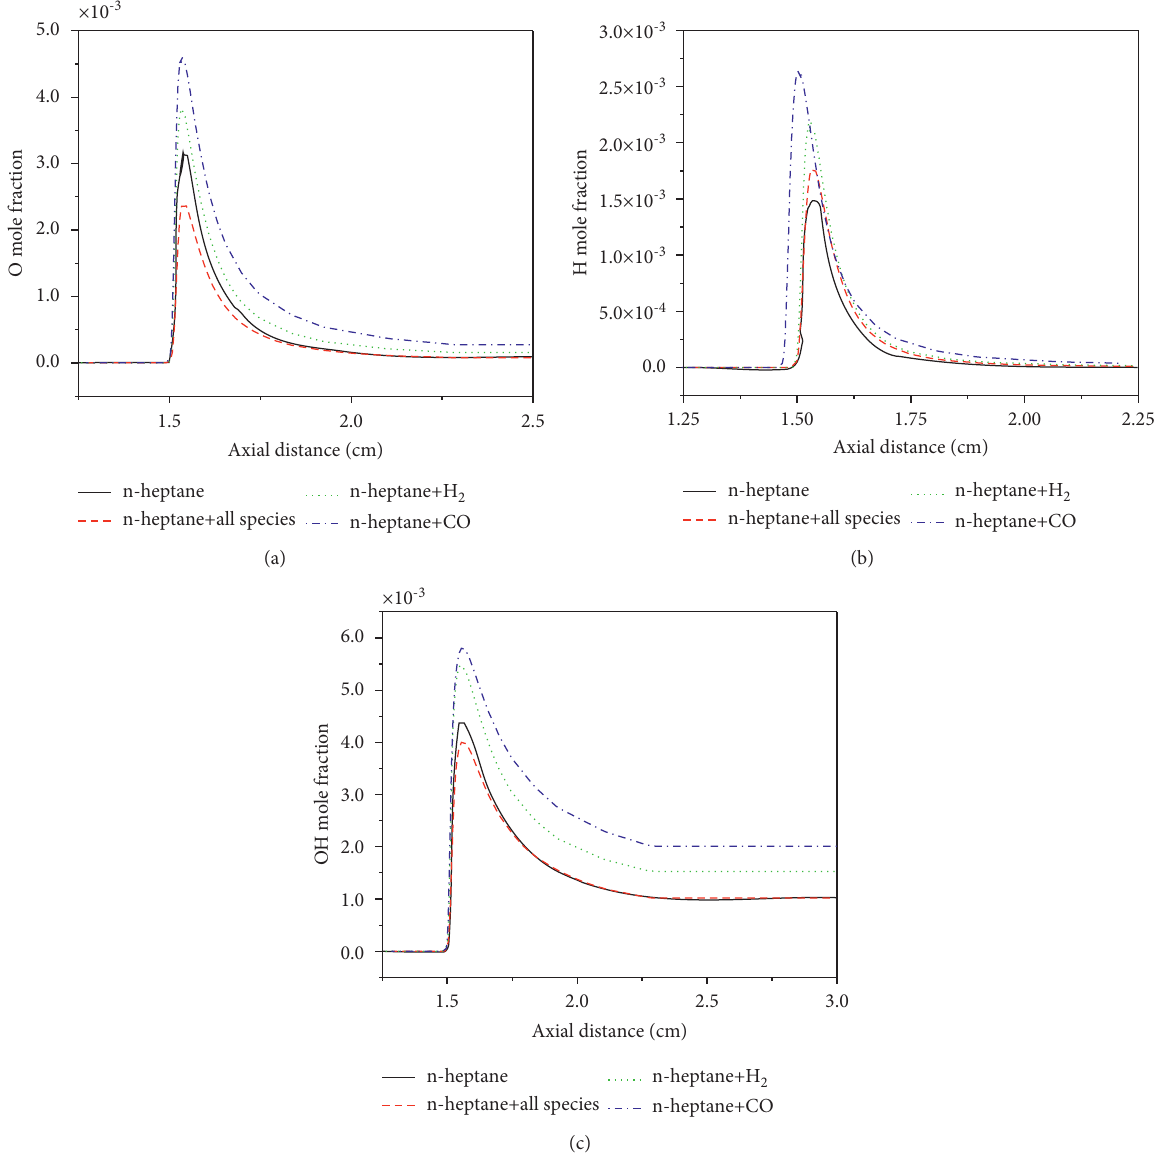
Figure 10: Axial distributions of O, H, and OH radicals in laminar flame of different reforming species and